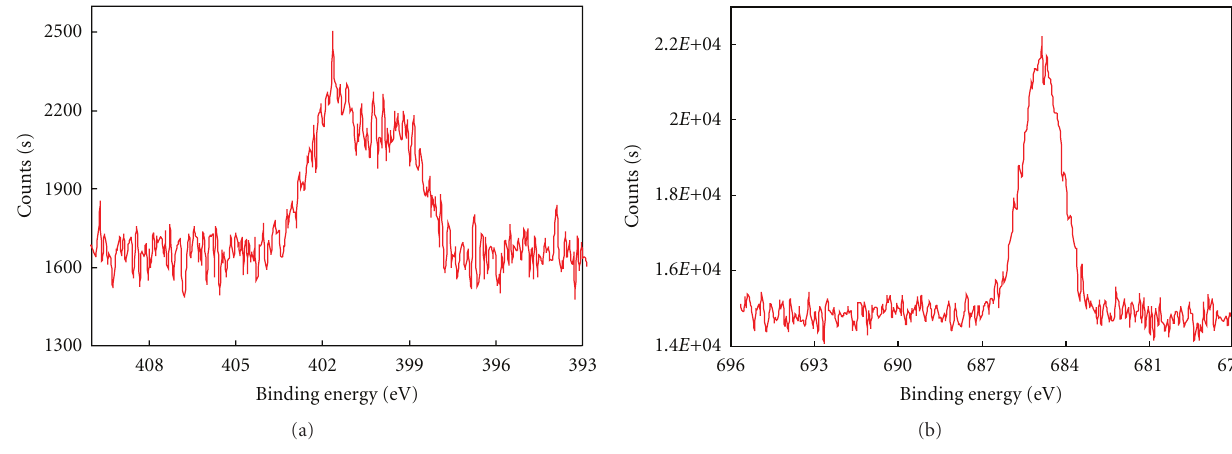
Figure 5: XPS spectra of NF400, (a) N1s and (b) F1s.